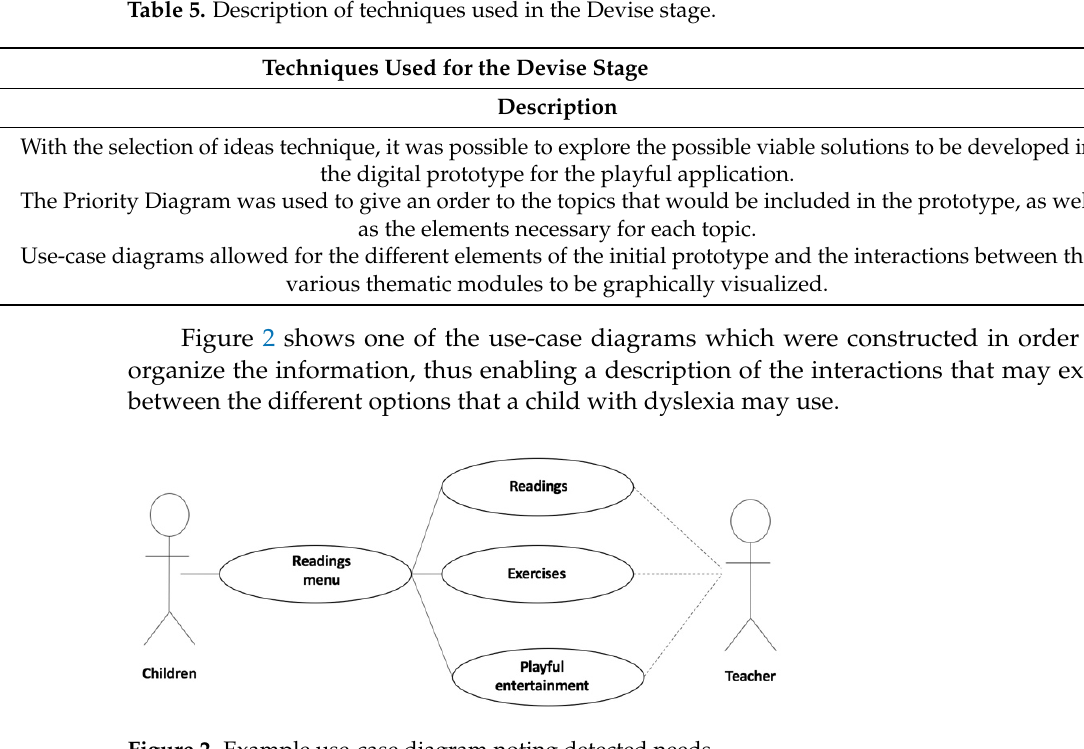
Figure 2. Example use-case diagram noting detected needs.